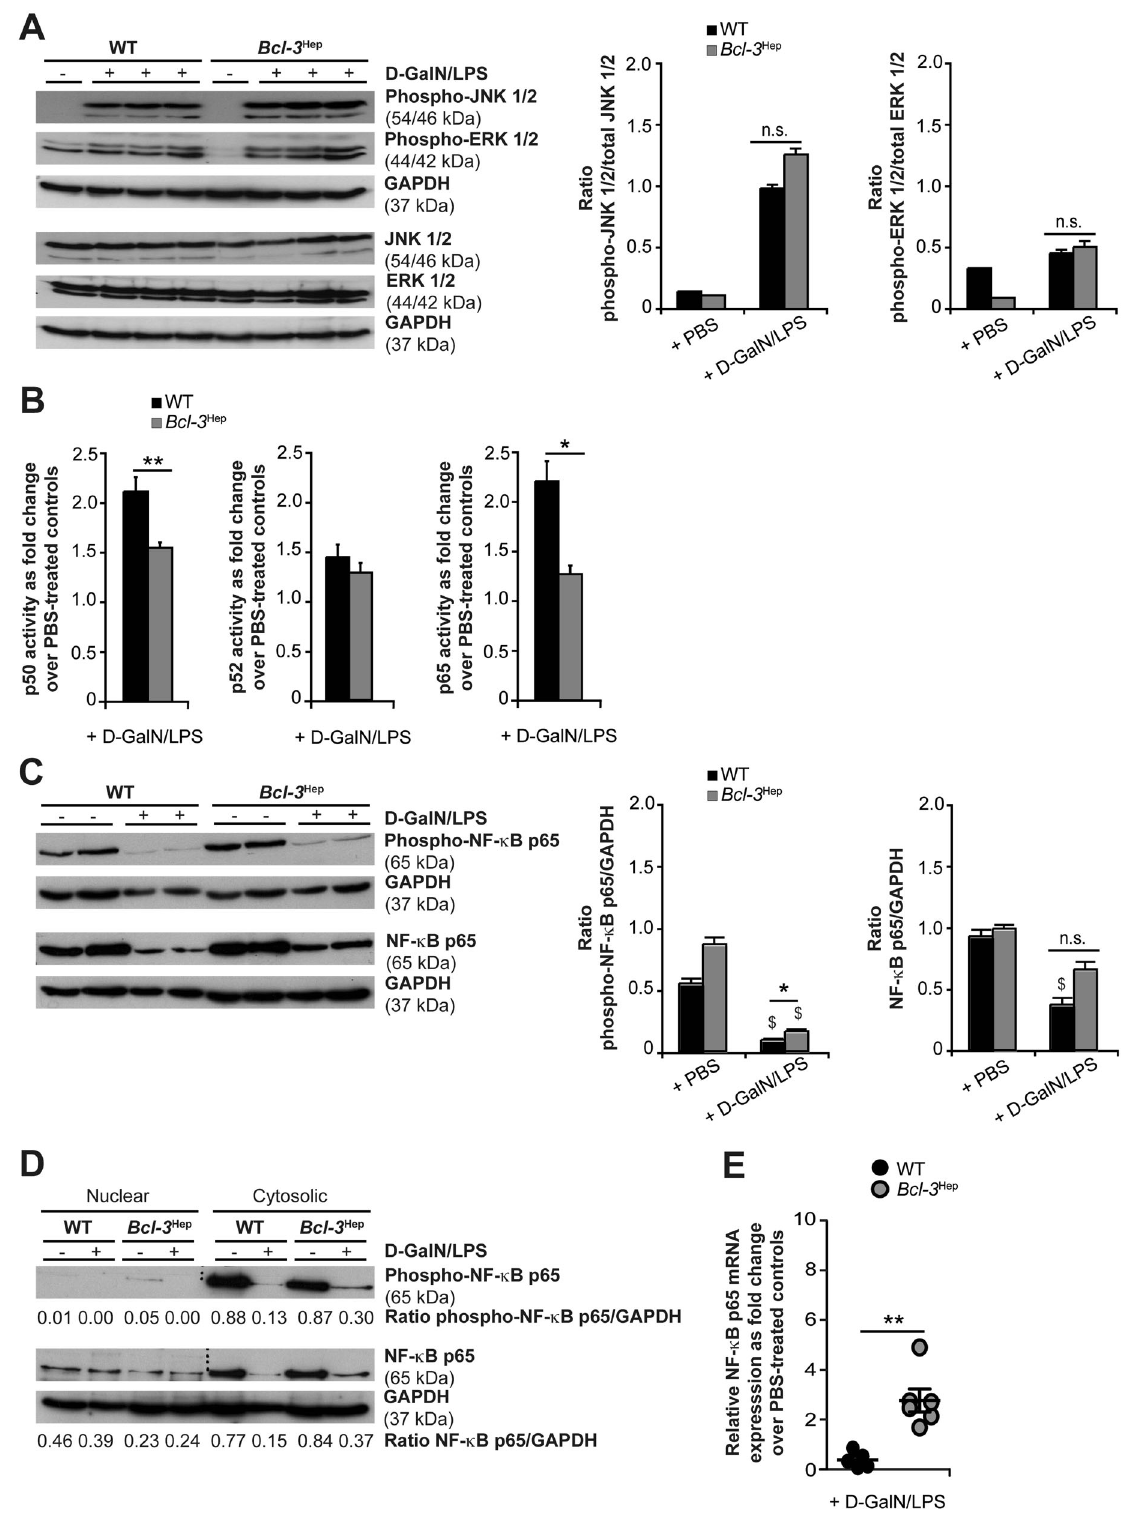
Fig. 3 Activation of hepatic JNK, ERK and NF- κ B in Bcl-3 Hep and WT mice in response to d-GalN/LPS. A Immunodetection of phospho-JNK (Thr183/Tyr185), phospho-ERK (Thr202/Tyr204) and total JNK/ERK protein in whole liver tissue lysates from Bcl-3 Hep and WT mice at 4h post d-GalN/ LPS challenge. B NF- κ B p65, p50 and p52 activity was quanti fi ed by a functional binding assay. Ratio of relative NF- κ B p65/p50/p52 activity in d- GalN/LPS-challenged Bcl-3 Hep vs. WT mice is shown (means of n = 7 WT + d-GalN/LPS, n = 8 Bcl-3 Hep + d-GalN/LPS and n = 7 PBS-treated controls per genotype ±SEM). C Immunoblotting of phospho-NF- κ B p65 (Ser536) and total NF- κ B p65 in whole liver tissue lysates and D after cytosolic vs. nuclear cell fractionation. E Relative hepatic NF- κ B p65 gene expression in d-GalN/LPS-challenged Bcl-3 Hep vs. WT mice as fold change over PBS- treated controls (means of n = 6 mice per genotype ±SEM). In A , C and D representative immunoblots with densitometric analysis are shown. * p < 0.05, ** p < 0.01 for WT vs. Bcl-3 Hep and $ p <0.05 for PBS vs. d-GalN/LPS using unpaired, two-tailed Student ’ s t -test ( A – C ) or Mann – Whitney U test ( E ). Cell Death and Disease (2022)